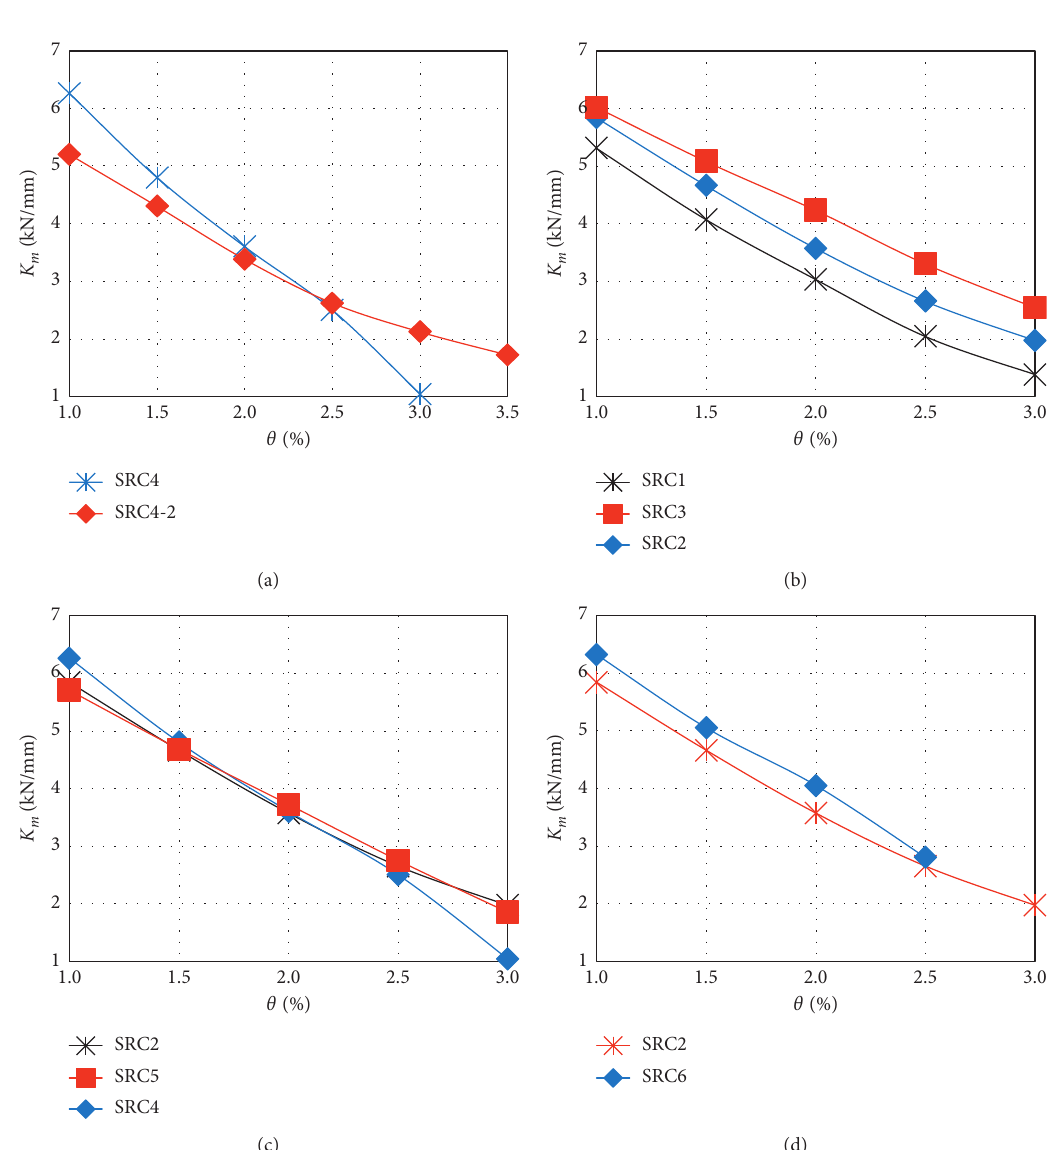
− θ ) of specimens. Effect of (a) cyclic loading number on K m